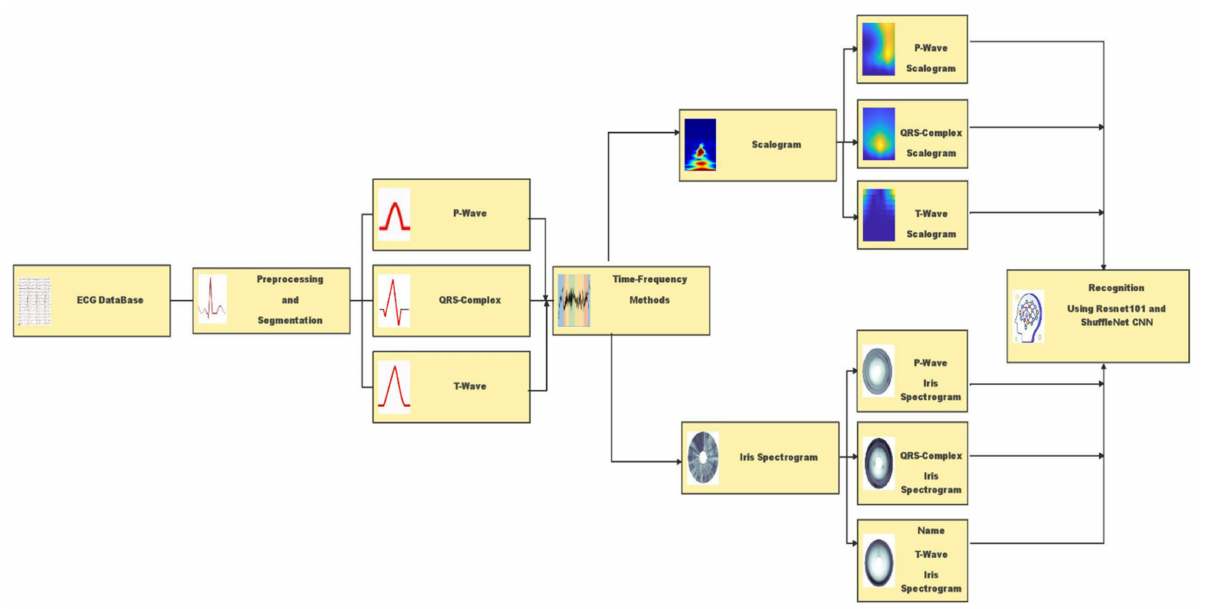
Figure 2. Block diagram of the proposed